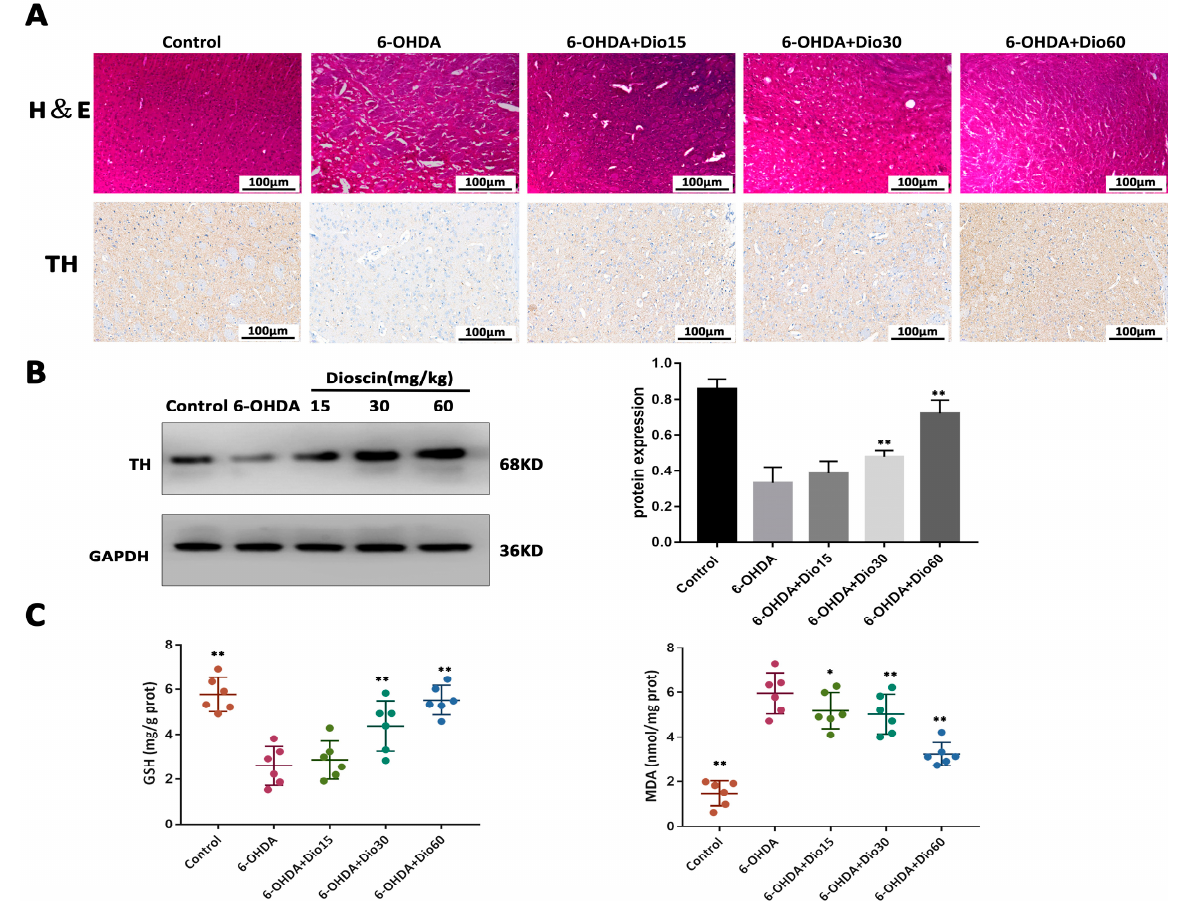
Figure 5. Regulation effect of dioscin on tyrosine hydroxylase (TH), glutathione (GSH) and malondialdehyde (MDA) levels. ( A , B ) Effects of dioscin on tissue structure and TH expression in rats ( n = 3). ( C ) Effects of dioscin onGSH and MDA expression in rats ( n = 6). All data are given as mean ± SD. * p < 0.05 and ** p < 0.01 compared with the 6-OHDA group.